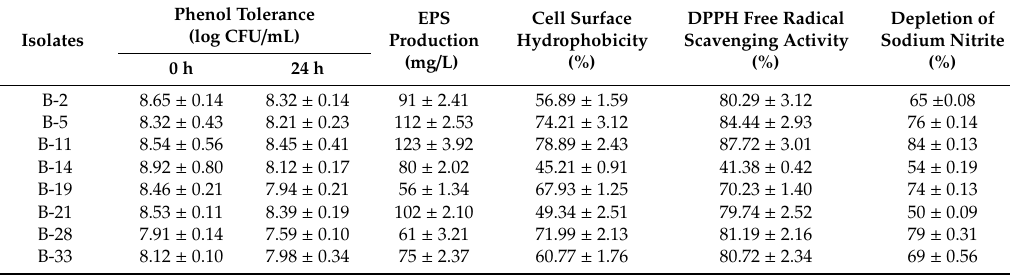
Figure 1. Survival (%) of isolates under gastrointestinal conditions ( a ) Tolerance to low pH (2 and 3) ( b ) Tolerance to di ff erent concentrations of bile salt i.e., 0.1%, 0.5% and 1%. Each value represents the mean value ± standard deviation (SD) ( n = 3). Bars with di ff erent lower-case letters are significantly di ff erent ( p < 0.05). Table 2. Phenol tolerance, EPS production, Cell surface hydrophobicity, DPPH free radical scavenging activity and Depletion of sodium nitrite by the isolates (means ± SD).